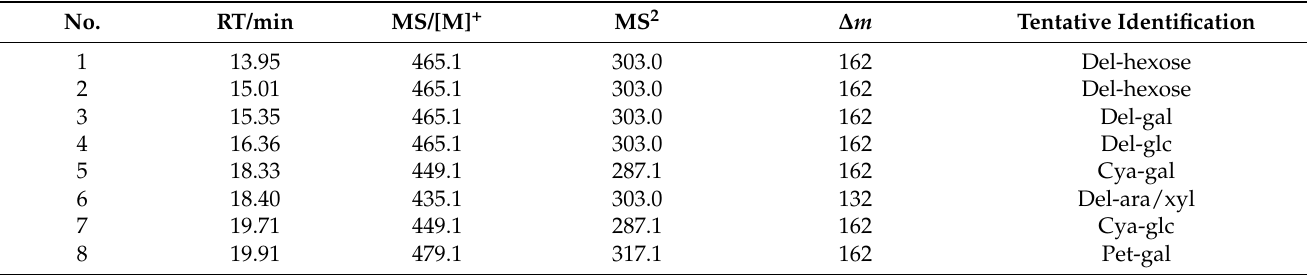
Figure 1. UPLC-QTOF-MS/MS total ion flow diagram of anthocyanin components in blueberries. Table 3. UPLC-QTOF-MS/MS identification of anthocyanin components in